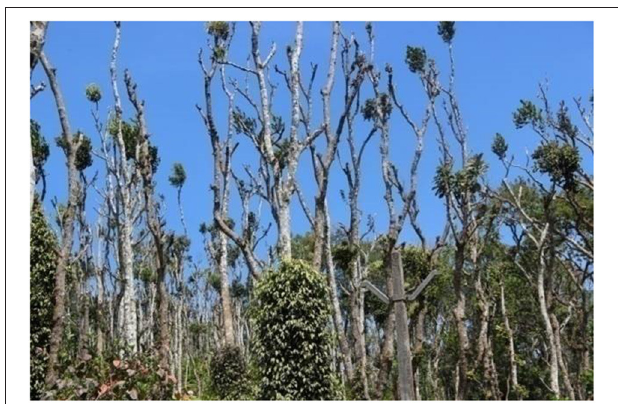
FIGURE 2 | Roughness and shape of the pruned forest trees immediately after shade lopping in cardamom